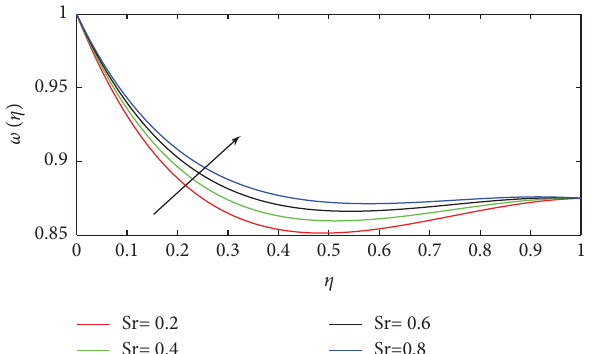
Figure 14: Temperature profles for the diferent values of Sr.